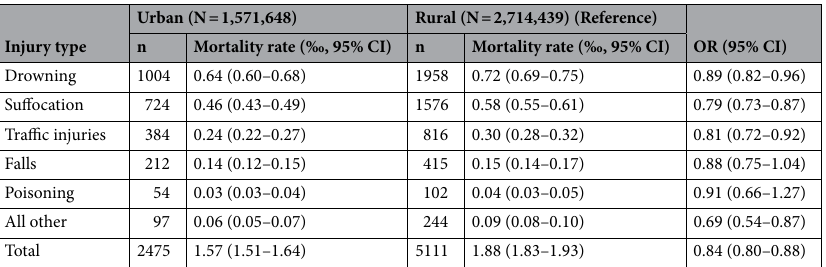
Table 5. Injury-related under-five mortality rate by residence. N number of live births, OR crude odds ratio, CI confidence